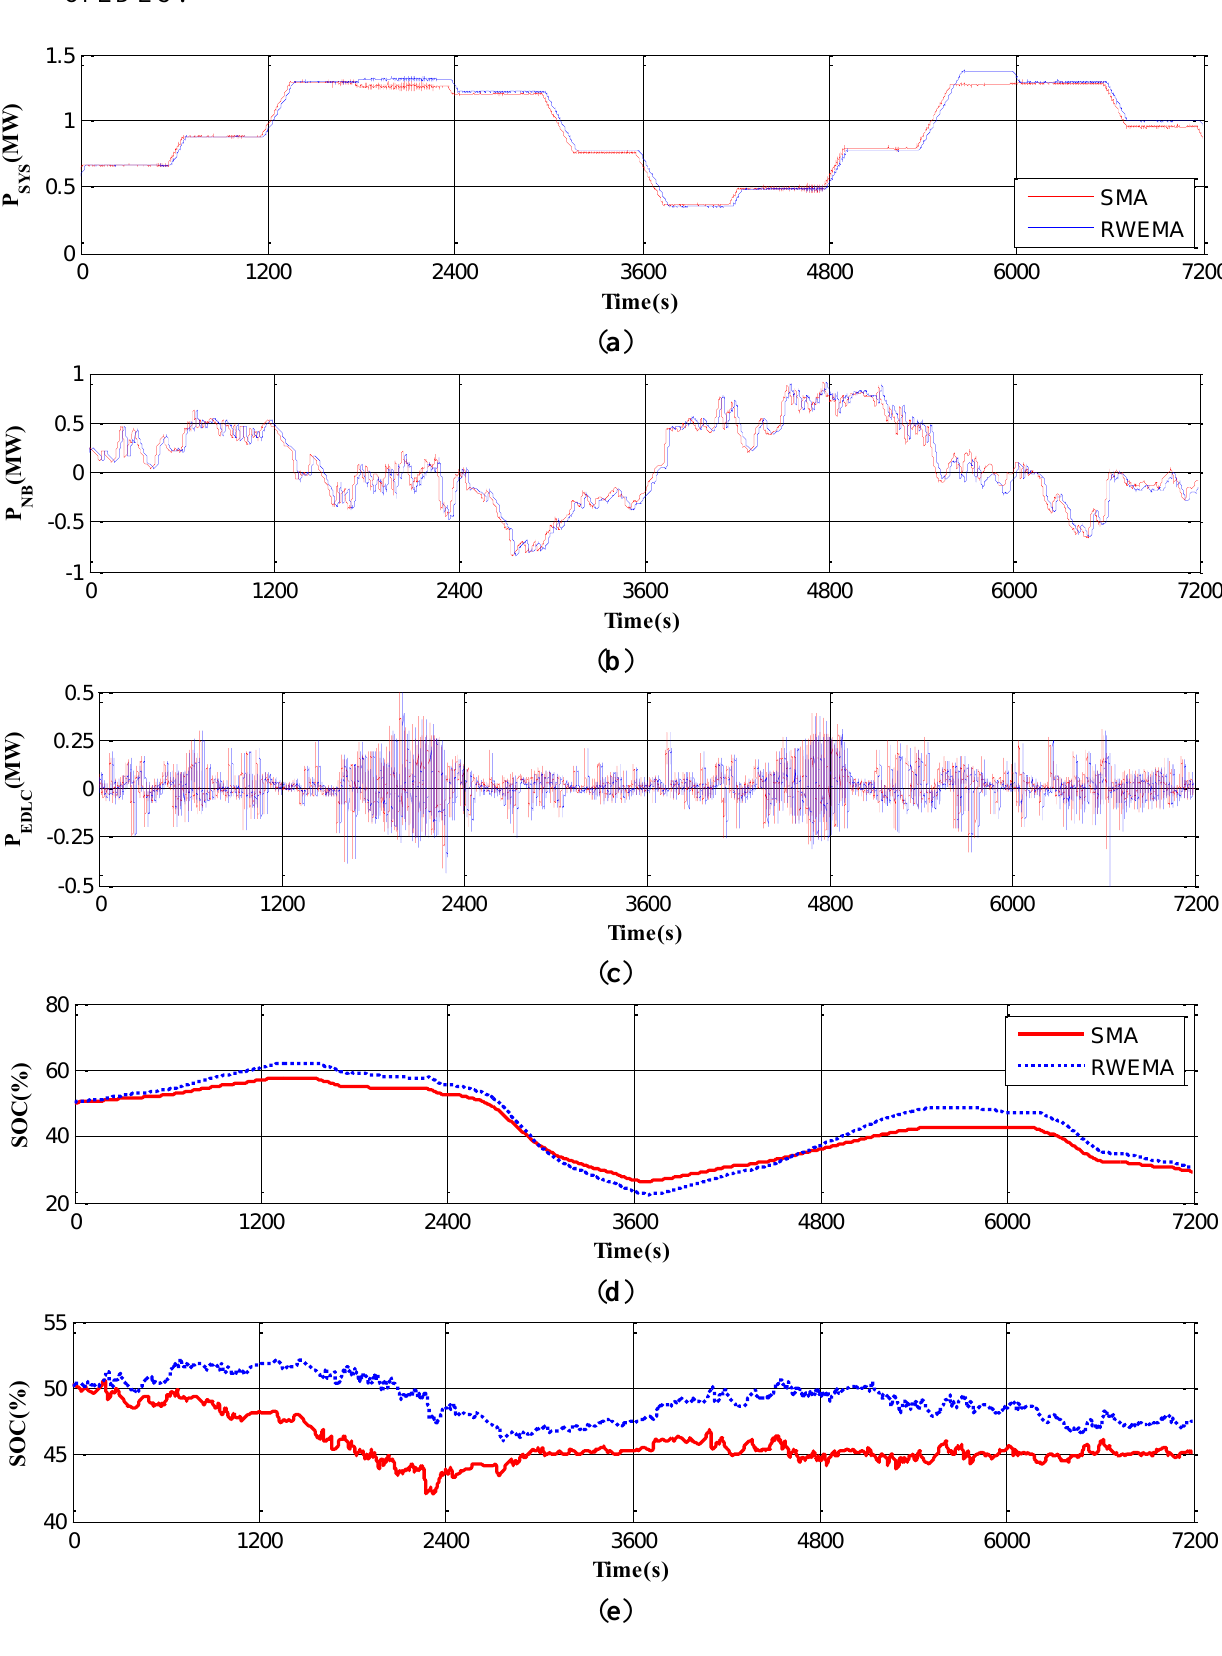
Figure 12. Simulation results for Case 2 with Wind Pattern 2: ( a ) total power output; ( b ) NB power output; ( c ) EDLC power output; ( d ) SOC level of NB; and ( e ) SOC level of